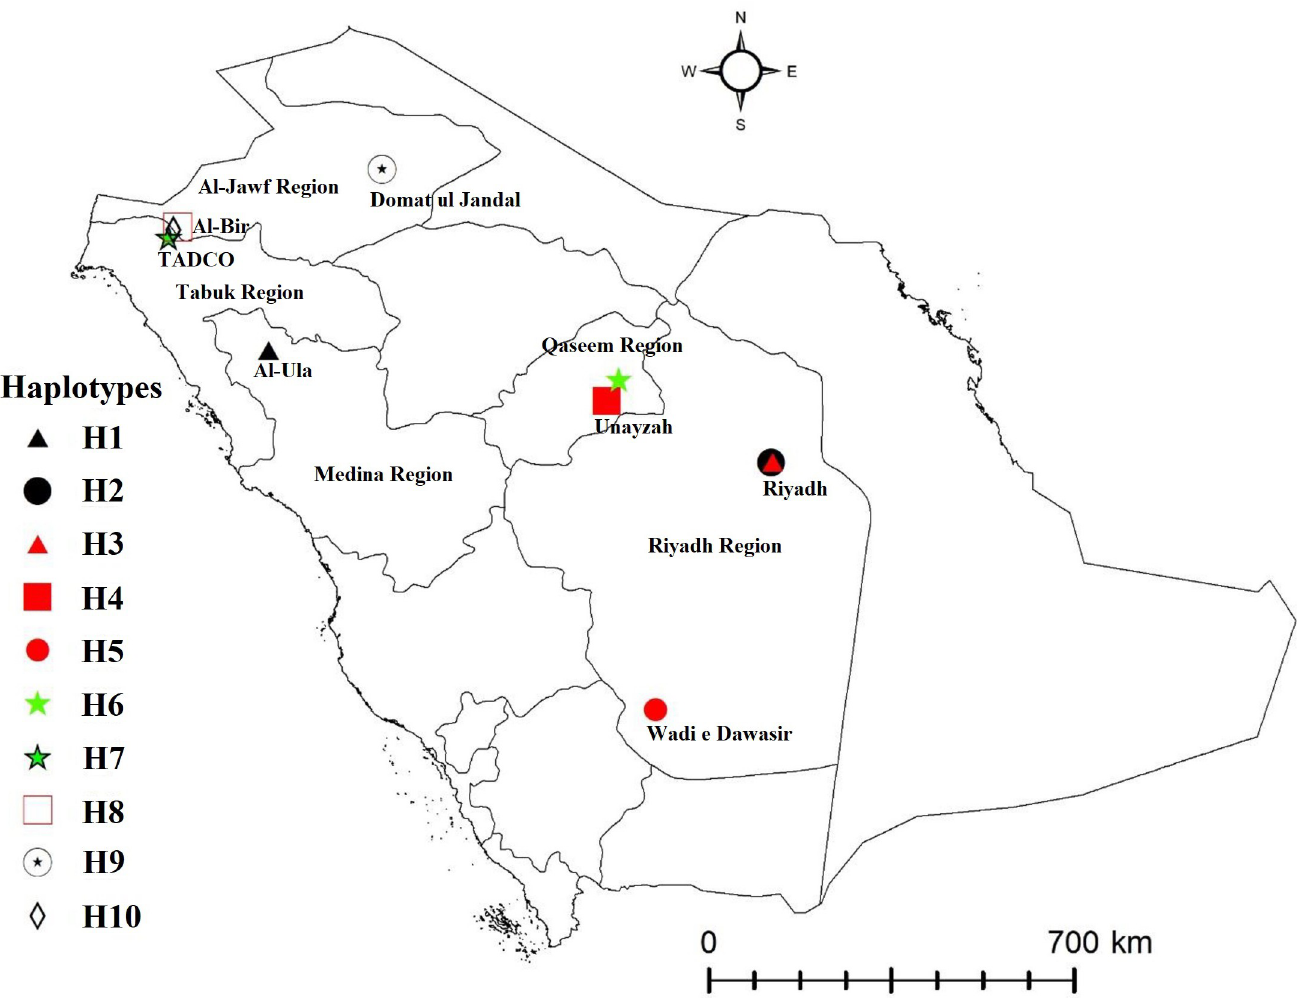
Fig 1. Geographic distribution of 10 different populations of Eutetranychus orientalis in Saudi Arabia (ArcGis 10.5., esri.com computer software).